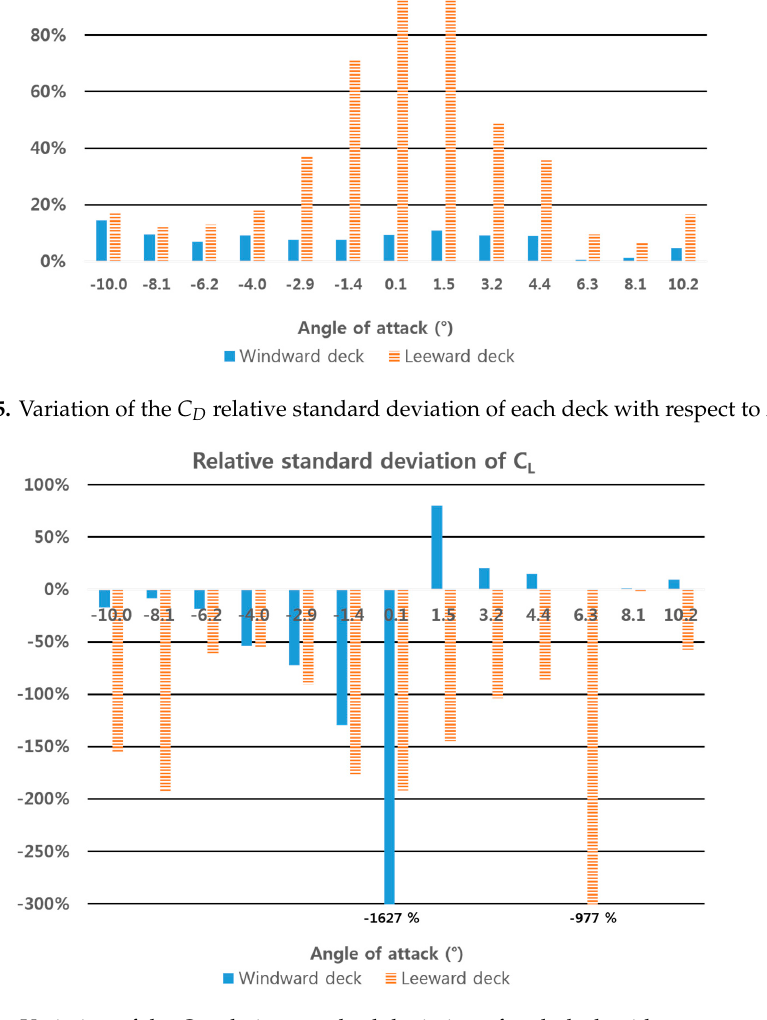
Figure 16. Variation of the C L relative standard deviation of each deck with respect to AoA.